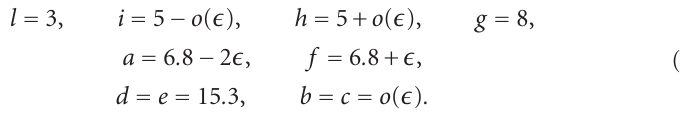
Example 5.2. There are three equilibria in (0,1) 2 : a sink and two saddles. For small values of (cid:2) the basin of the sink is bounded by the stable manifold of one